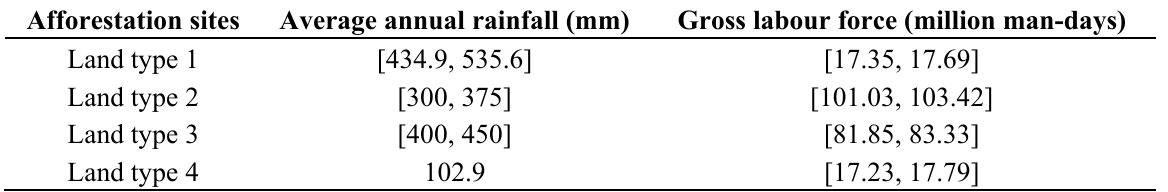
Table 8. Average annual rainfall at the CDM forestation sites and the gross labour force available in each area.